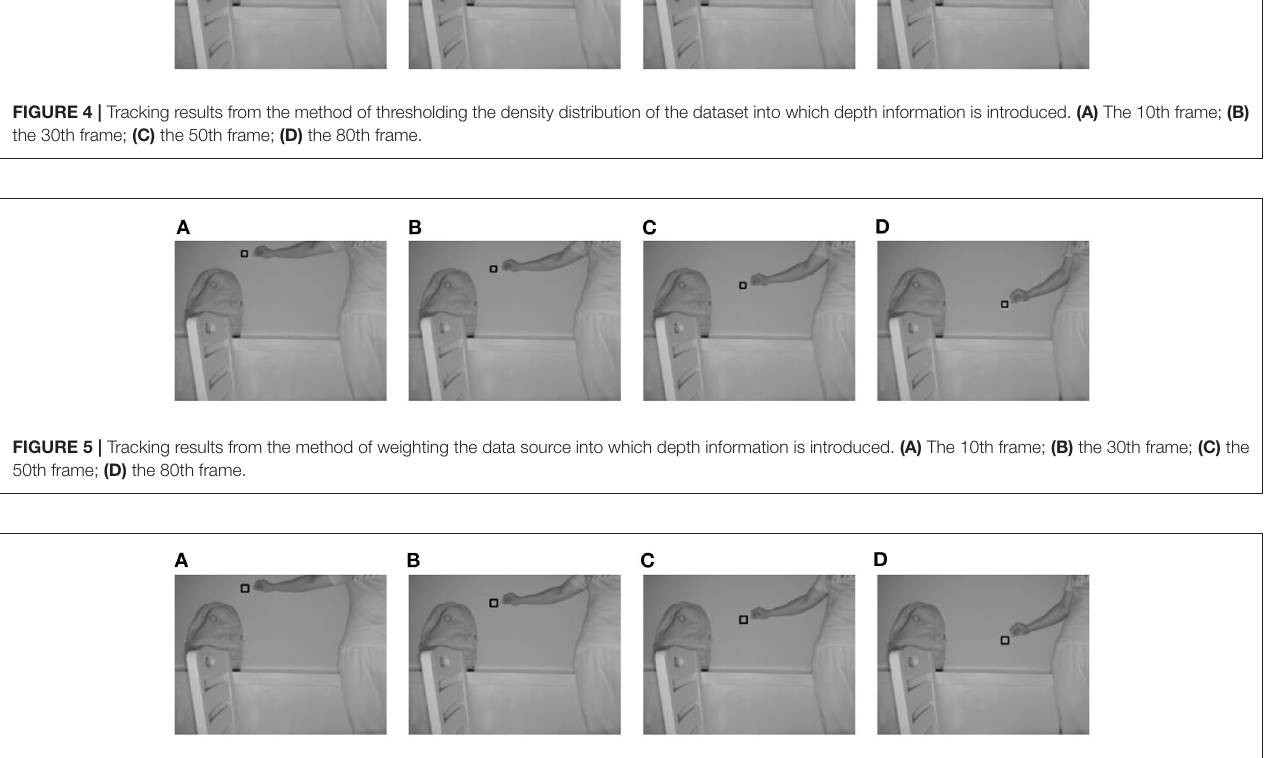
FIGURE 6 | Tracking results from the method of weighting the density distribution of the dataset into which depth information is introduced. (A) The 10th frame; (B) the 30th frame; (C) the 50th frame; (D) the 80th